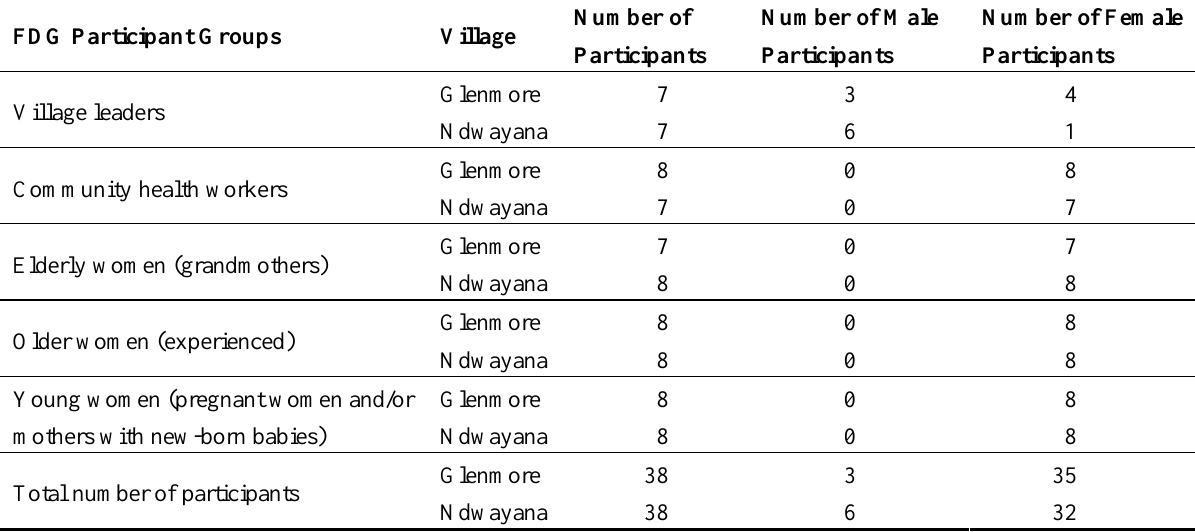
Table 1. Number of focus group discussions (FGD) participants from Glenmore and